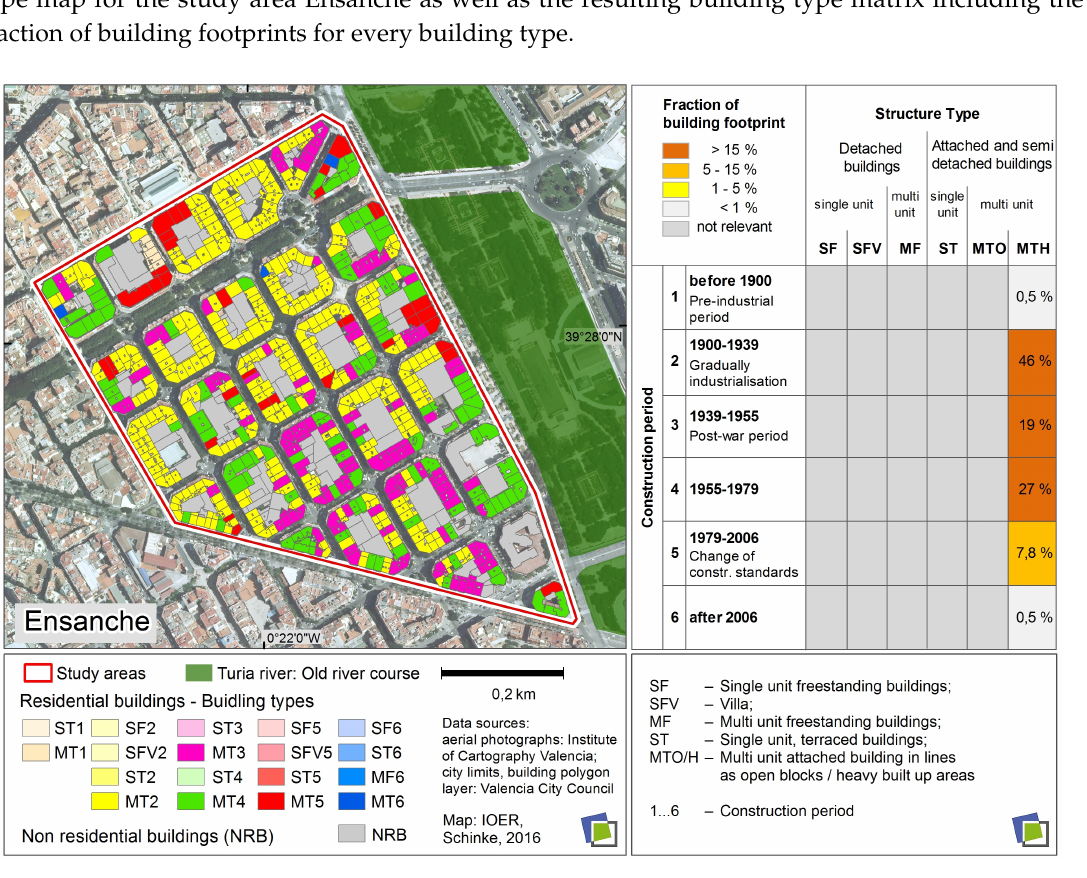
Figure 5. Building type map ( left ) and Building type matrix ( right ) of the study area